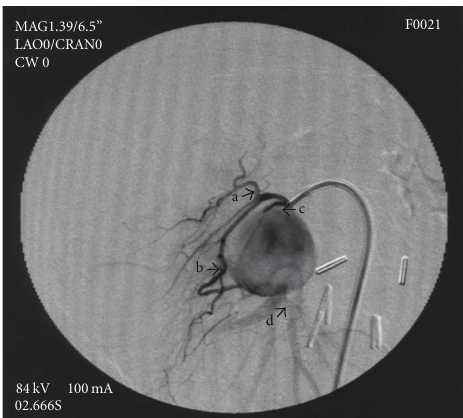
Figure 1: 25-years-old male patient with SMA pseudoaneurysm. Transverse CT scan in delayed venous phase (45 seconds), slice thickness showing oval hyper vascular lesion between aorta and inferior vena cava 27 mm in diameter.